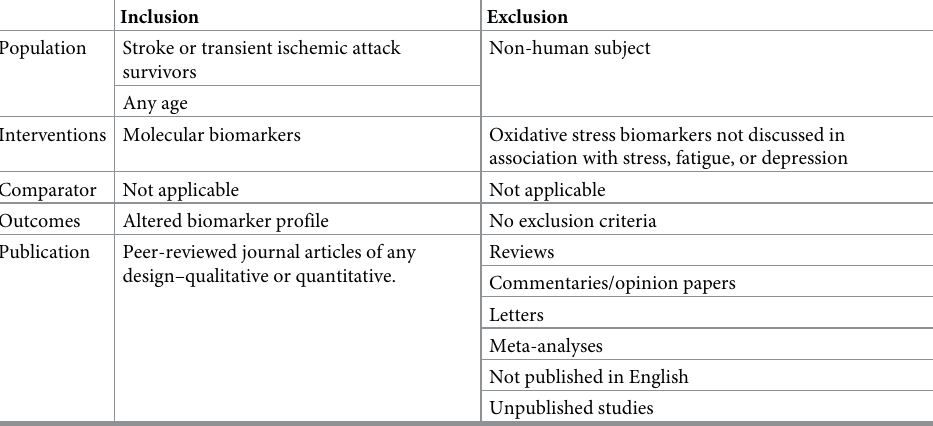
Table 1. Eligibility criteria for screened